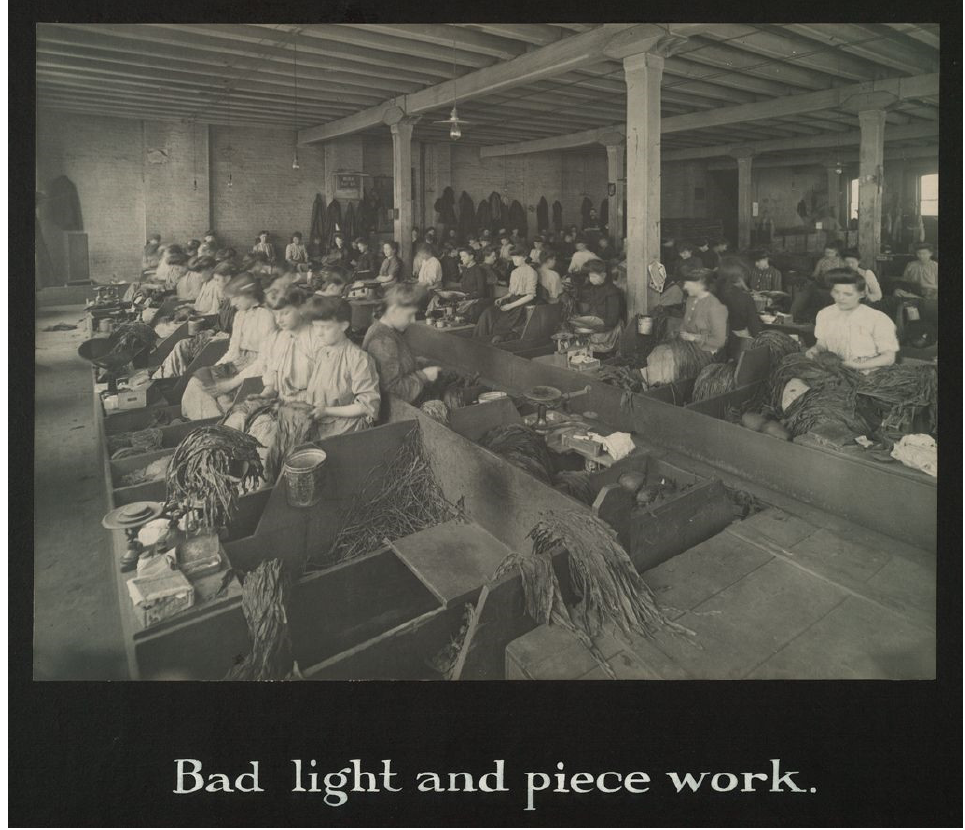
Figure 19. Lewis Hine 1909. Stripping Tobacco by the Pound. Image included in Elizabeth Beardsley Butler’s ([1984] 1909) Women and the Trade (in Greenwald 1984, p. 78). Image courtesy of Harvard Art Museums/Fogg Museum, Transfer from the Carpenter Center for the Visual Arts, Social Museum Collection.